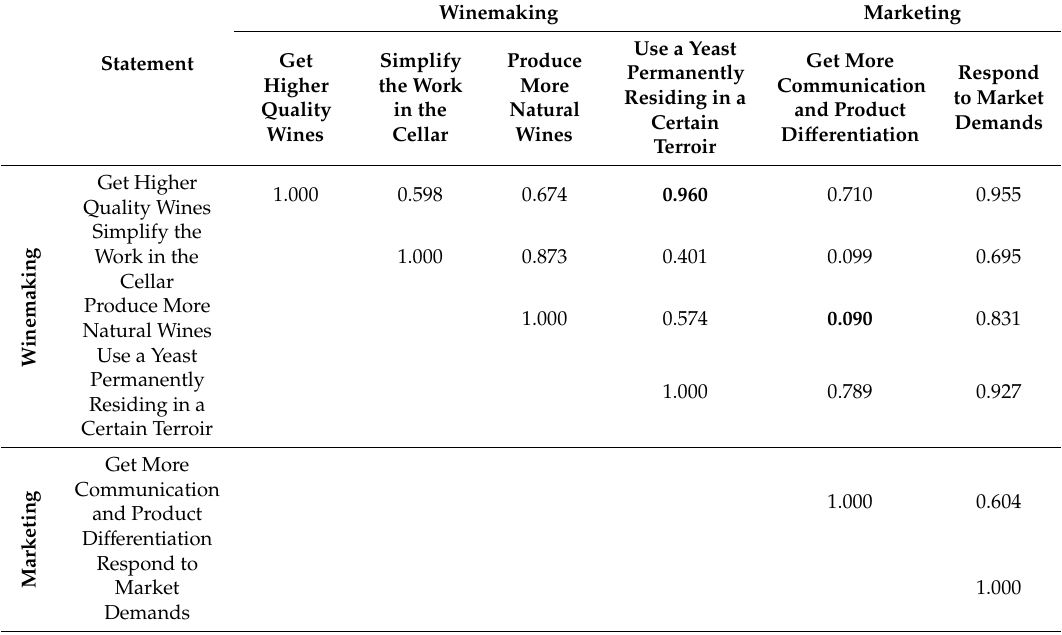
Table 5. Correlation indexes among the statements related to the use of indigenous